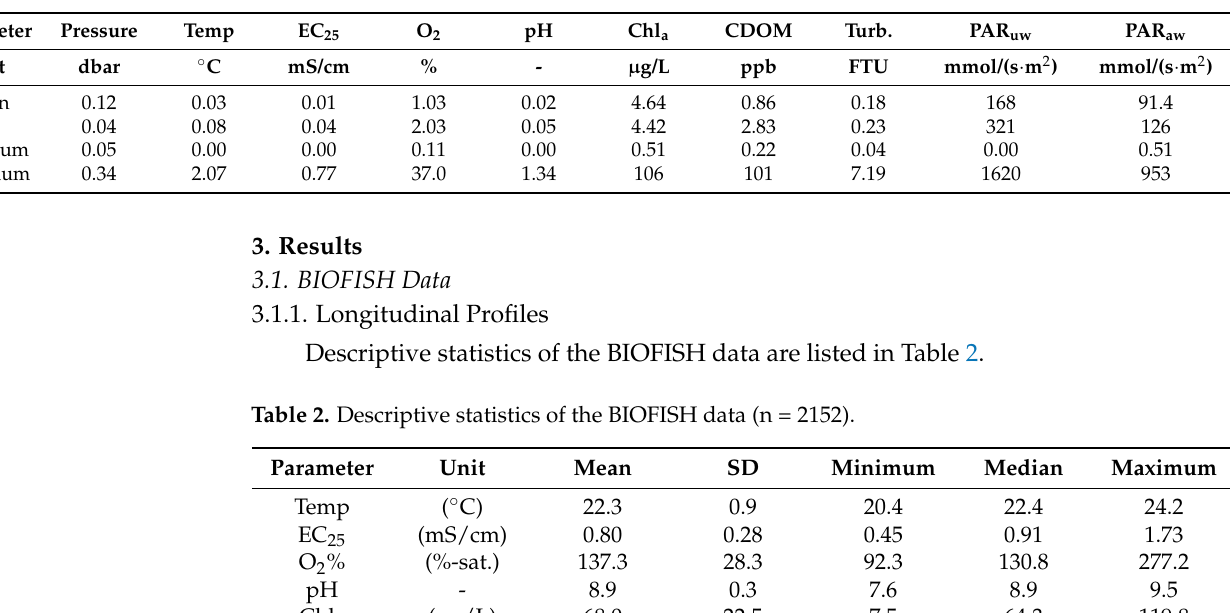
Table 1. Mean, standard deviation (SD), minimum and maximum of the 5th to 95th percentile ranges of every minute of BIOFISH data (n = 2152).